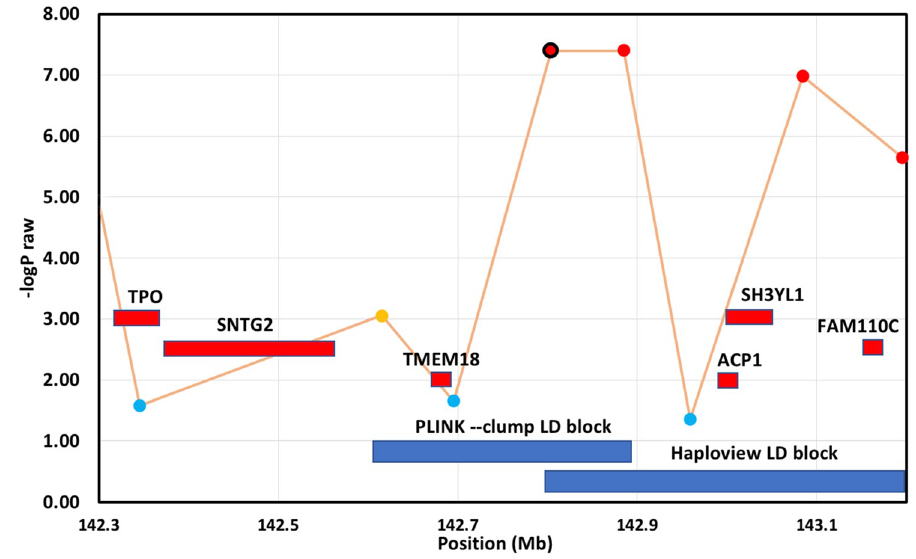
Fig 4. Haplotype blocks around the significant region on chromosome A3. The block identified by PLINK–clump, and the block identified by HAPLOVIEW are shown in blue. SNP variants are plotted as -log10 p raw , and are shown with colours indicating the amount of LD with the most significant SNP, as follows: red (r2 > 0.8), orange (r2 > 0.2) and blue (r2 < 0.2). The rightmost SNP is at the end of the chromosome.